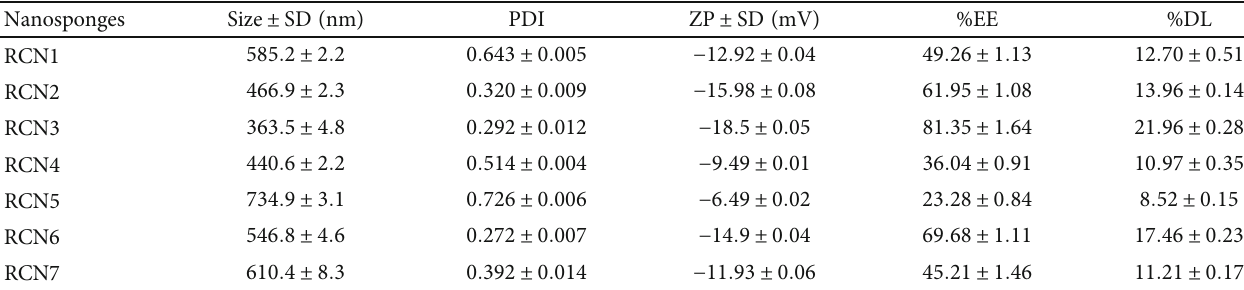
Table 2: Evaluation of ribociclib-loaded nanosponges (RCN1-RCN7). Nanosponges